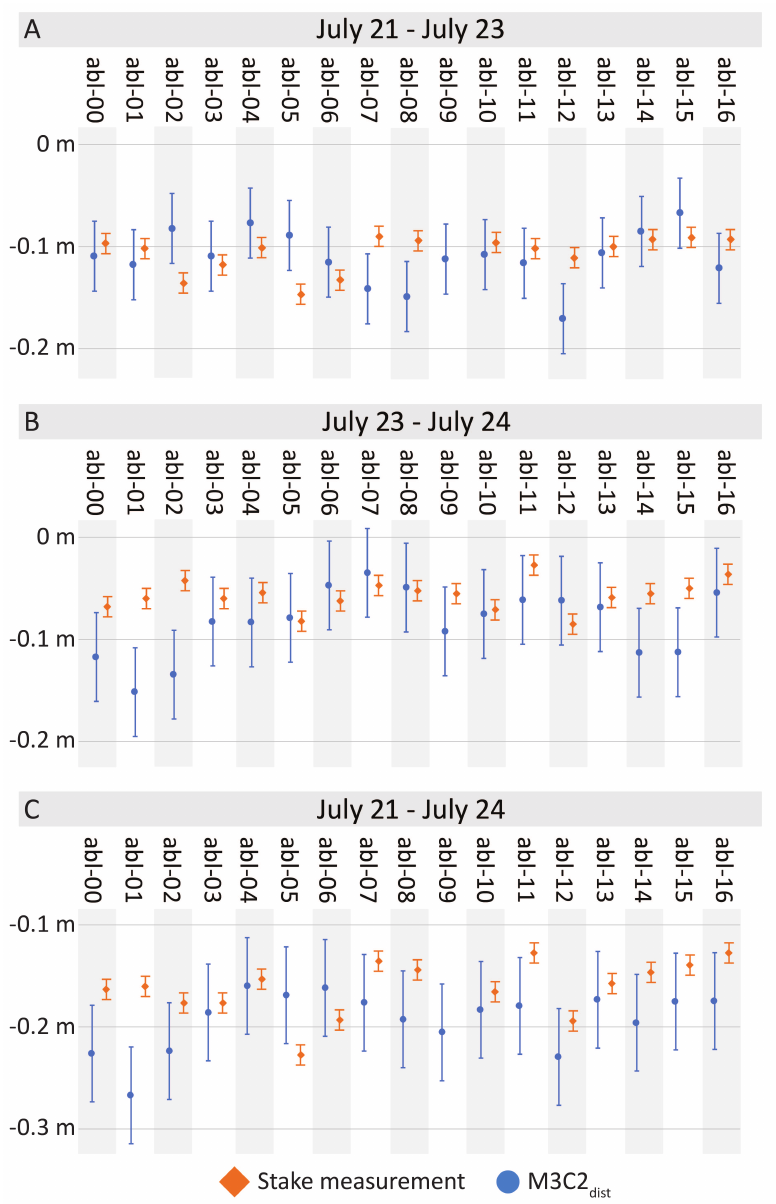
Figure 5. Comparison of surface change from point cloud differences and in situ measurements at ablation stake locations for: ( A ) 21–23 July; ( B ) 23–24 July; and ( C ) 21–24 July. The average M3C2 dist within 0.25 m of each ablation stake is shown. Error bars for ablation stake measurements are ± 0.10 m; for M3C2 dist error bars are equal to the RMSE for the time